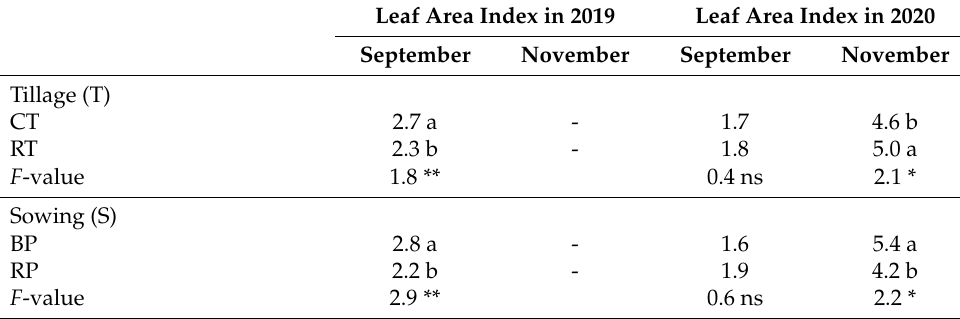
Table 3. Effects of tillage, sowing, and soil compaction methods on leaf area index at the